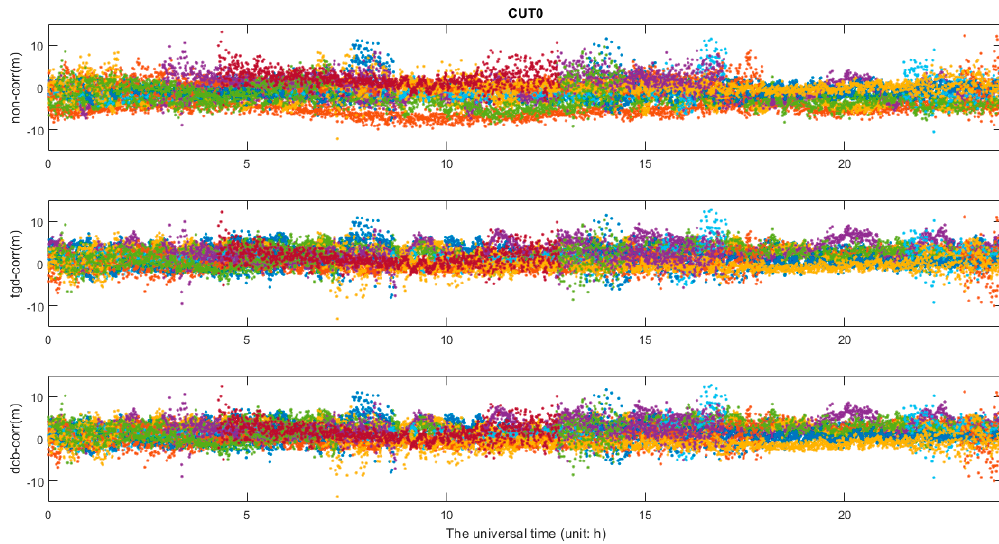
Figure 11. Pseudorange residuals: b1b3 GPS/BDS/ Galileo PPP solutions on CUT0 station.